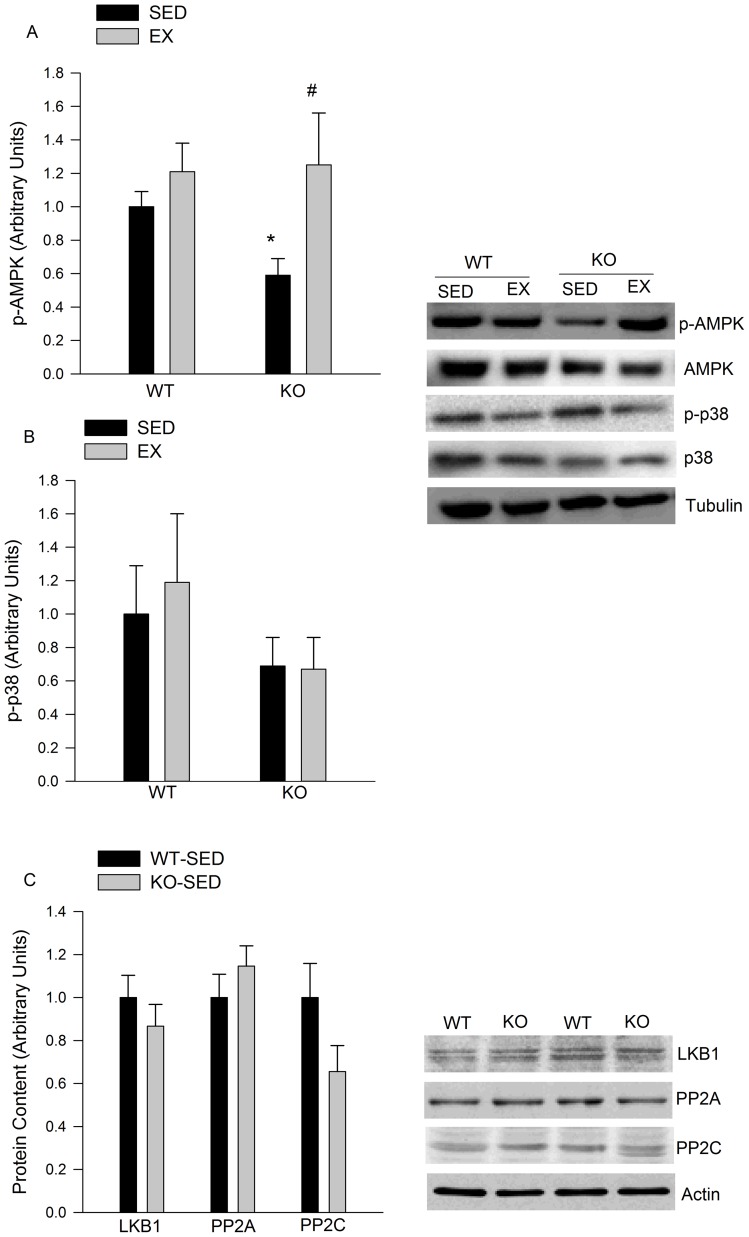
Exercise mediated AMPK signalling.A) P-AMPK is reduced in eWAT from sedentary IL-6−/− compared to WT mice and increased following an acute bout of exercise in IL-6−/− mice only. B) Exercise did not change the phosphorylation of p38 in either genotype. C) There is no differences for the protein expression of LKB1, PP2A and PPAC between WT and KO SED group. Data are presented as means + SE for 10–12 animals per group. Representative Western blot images are shown to the right of the quantified Western blot data. * P<0.05 versus WT SED. # versus IL-6−/− SED in A.